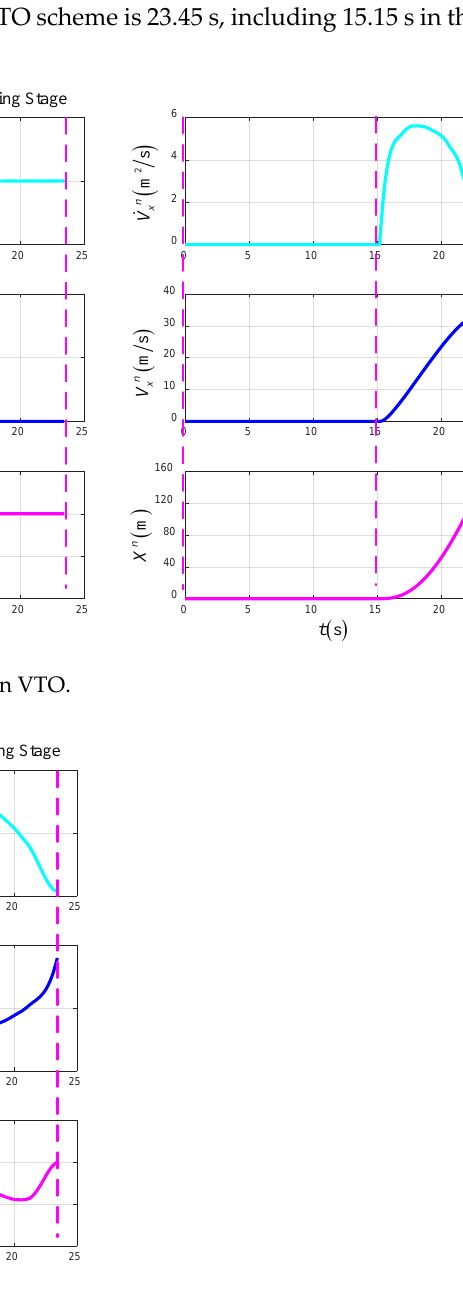
Figure 12. Forces analysis in TTO.